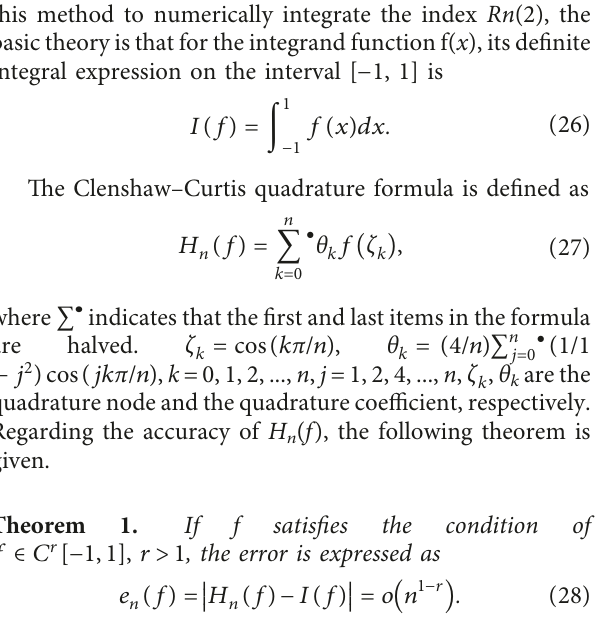
90 μ m, B 30 μ m). (a) Rn (1). (b) Rn (2). (c) Rn (3). (d) Rn (cid:31) (cid:31)